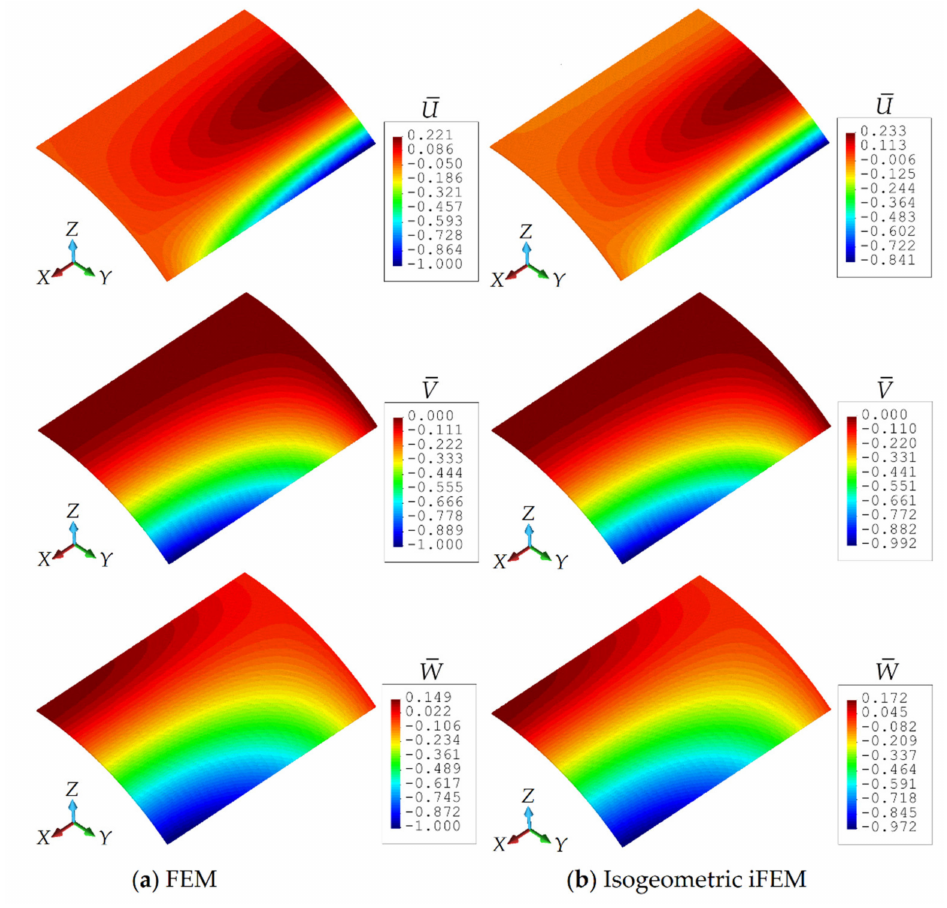
Figure 7. Contour plots of U , V , W displacements for Scordelis–Lo roof: Comparison between ( a ) high-fidelity finite element method (FEM) and ( b ) isogeometric inverse finite element method (iFEM) (n e = 4)